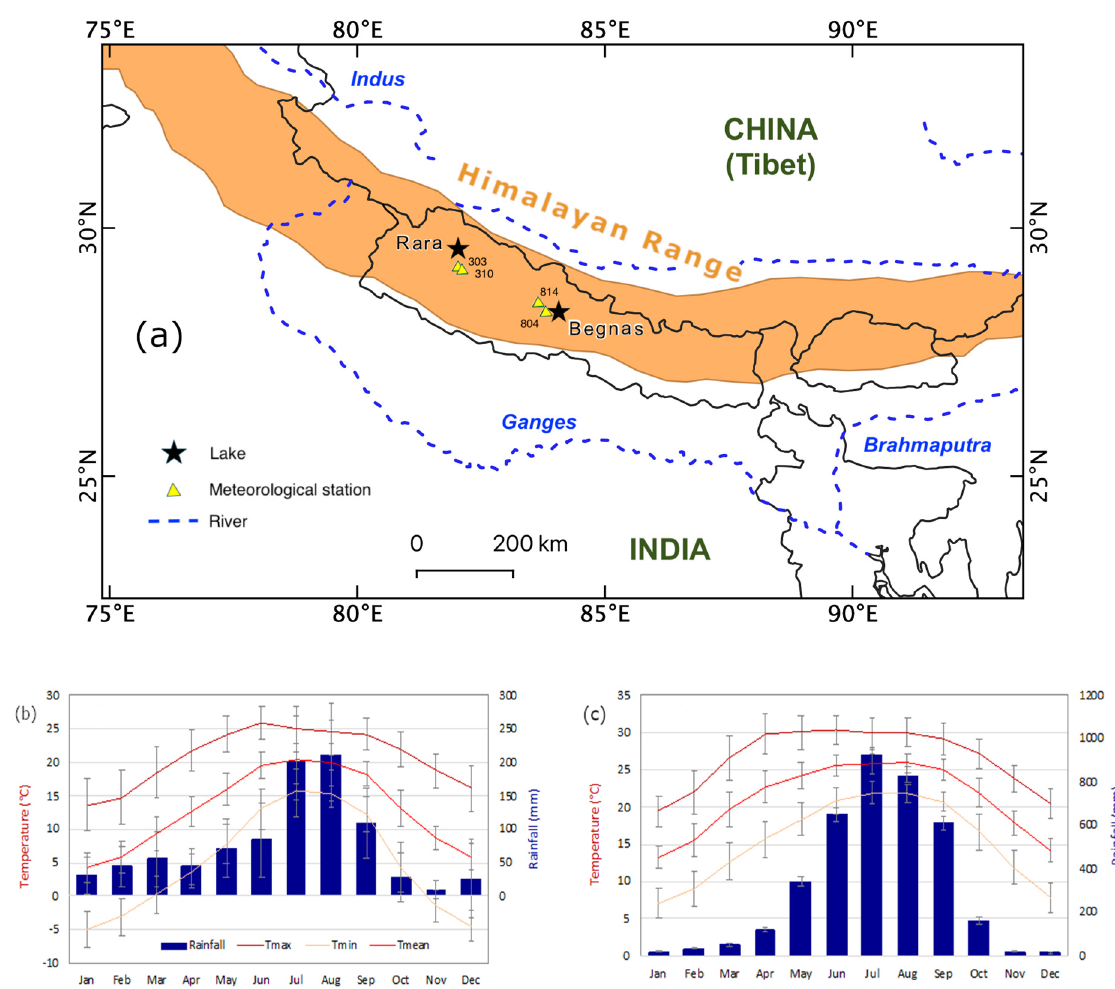
Figure 1. Location of the study areas: ( a ) Rara and Begnas Lakes in Nepal. Mean monthly cumulative rainfall and minT, MaxT, and MeanT for ( b ) Rara and ( c ) Begnas Lakes.